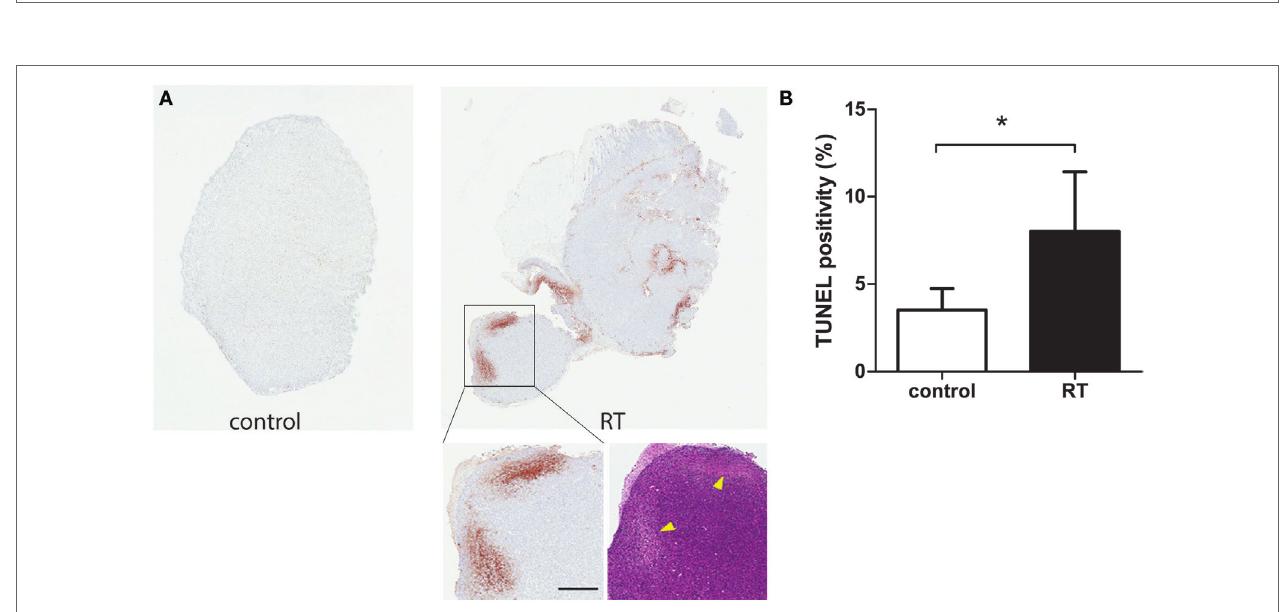
FigUre 3 | histological analysis of cell death after irradiation . (a) Representative images of TUNEL and H&E staining for control and irradiated tumor resected 40 h after irradiation. The arrowheads point to necrotic areas. Scale bar = 500 μ m. (B) Quantified TUNEL positivity for tumors resected 40 h after irradiation, expressed as % positivity ( n = 7/group, * p < 0.05).